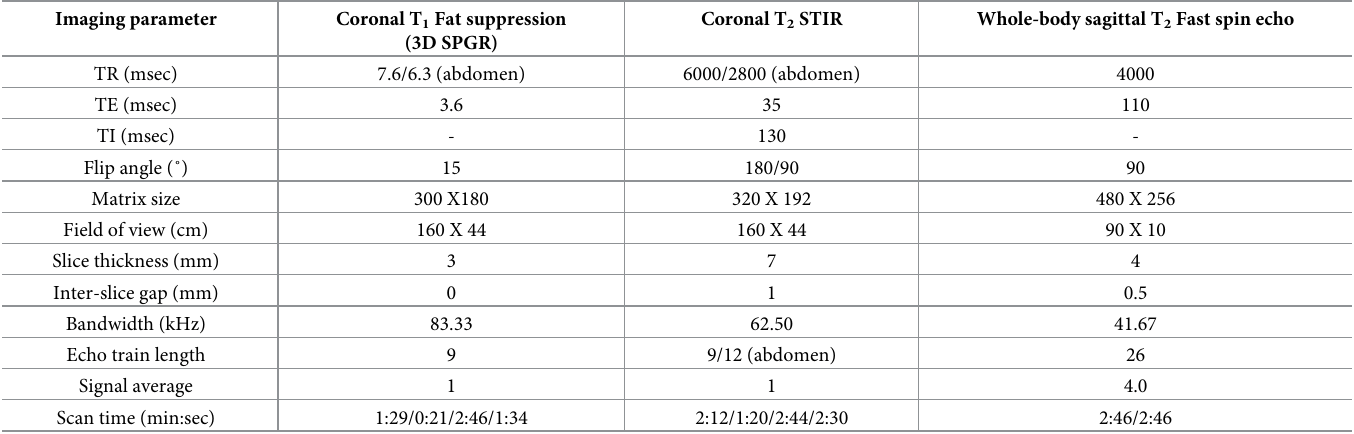
Table 1. Imaging parameters for MR